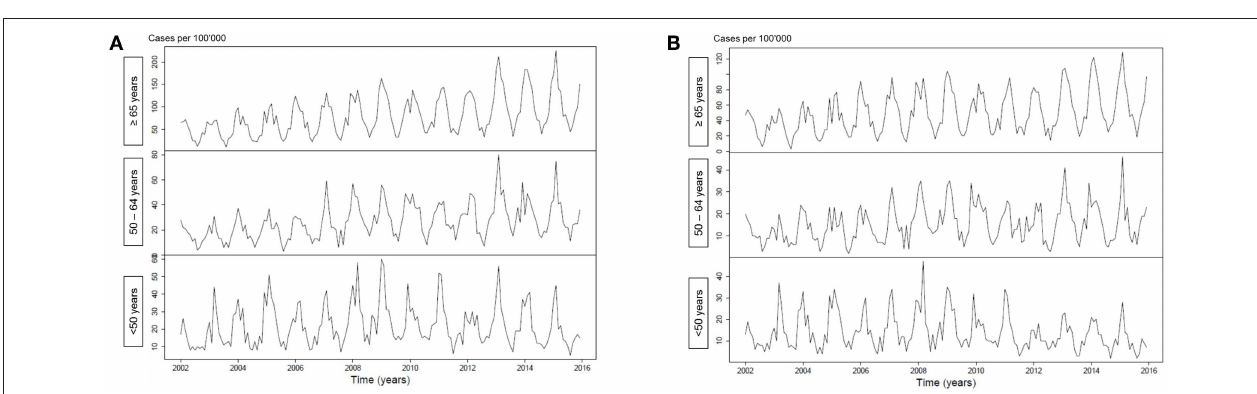
years (aRR: 1.16, 95%CI: 1.16–1.17) were independent risk